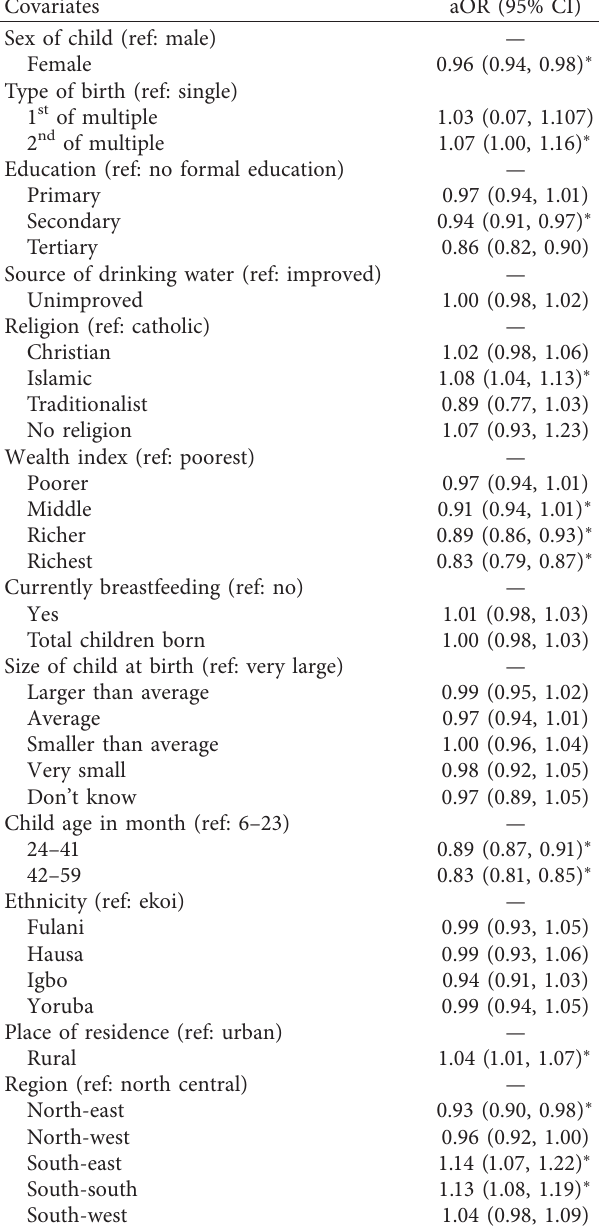
Table 4: Estimates of multilevel logistic regression model (NDHS 2018).